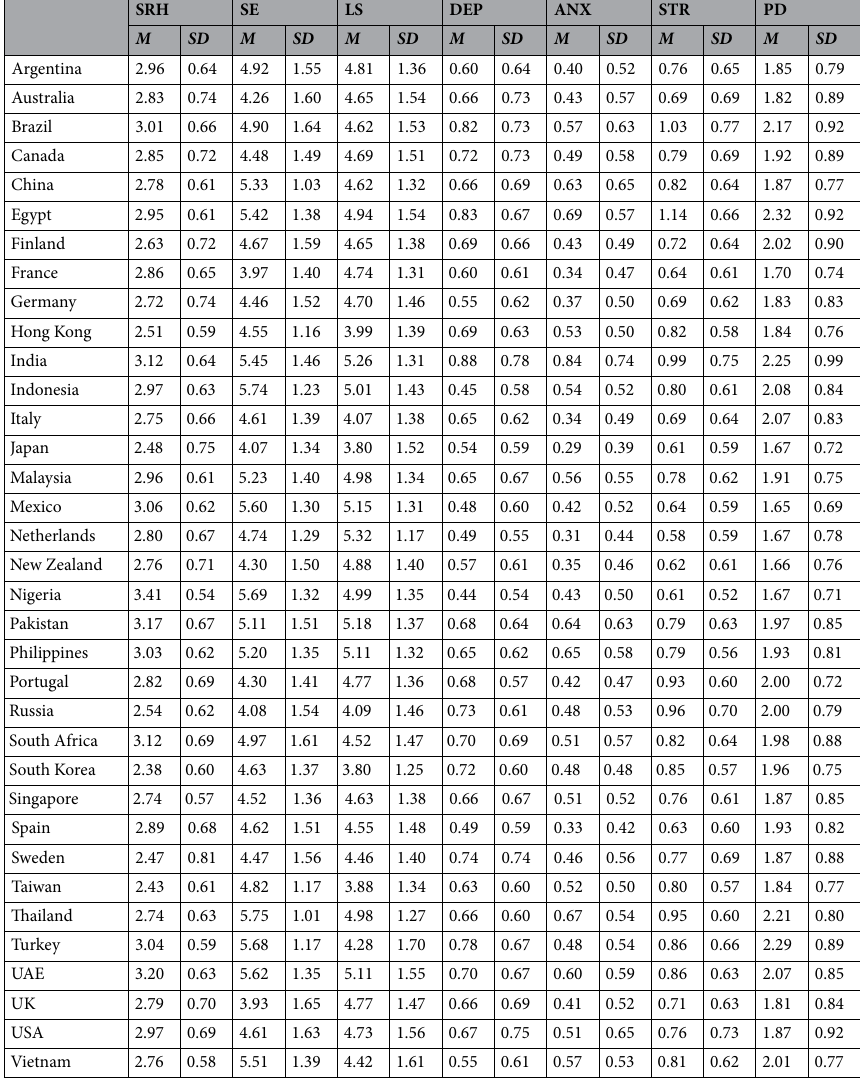
level) were associated with coronavirus anxiety, and hence multilevel regression was conducted to examine effects at the within-country level (individual level) after accounting for between-country variation. Results at the between-country level (country/society level) are reported in the supplementary appendix (see Table S6). Models were tested with random intercepts and fixed slopes across the 35 societies. Multilevel regression was conducted to examine the prediction of need for cognitive closure (NFC) on per- ceived vulnerability and threat response (see Table 3), controlling for the covariates of age, gender, and education level. First, age did not predict perceived vulnerability, b = − 0.00, β = − 0.02, p = 0.160, but positively predicted threat response, b = 0.00, β = 0.04, p = 0.001, indicating that old adults reported higher levels of threat response than younger adults. Gender (male = 1, female = 2) positively predicted both perceived vulnerability, b = 0.09, β = 0.07, p < 0.001, and threat response, b = 0.12, β = 0.09, p < 0.001. Compared with male participants ( M = 2.65, SD = 0.71 for perceived vulnerability; M = 3.25, SD = 0.73 for threat response), females scored higher in both factors of coronavirus anxiety ( M = 2.76, SD = 0.68 for perceived vulnerability; M = 3.36, SD = 0.68 for threat response). Education level (below high school or others = 1; high school = 2; above high school = 3) positively predicted both perceived vulnerability, b = 0.05, β = 0.04, p < 0.001, and threat response, b = 0.11, β = 0.08, p < 0.001, indicating that participants with higher levels of education scored higher in both factors of coronavirus anxiety than those with lower levels of education. NFC positively predicted both perceived vulnerability, b = 0.10, β = 0.10, p < 0.001, and threat response, b = 0.10, β = 0.10, p < 0.001. This supports our prediction that stronger need for cognitive closure is linked to higher coronavirus anxiety. Additional models with the random effects of NFC on perceived vulnerability and